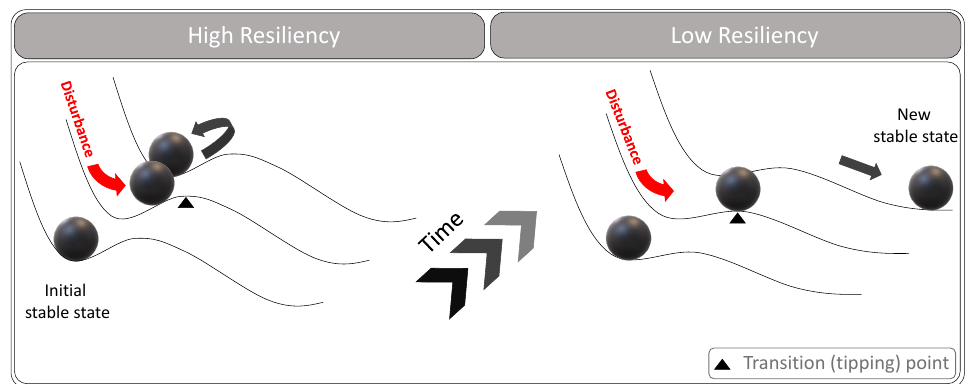
Figure 4. The response of a resilient and a non-resilient ecosystem to an external